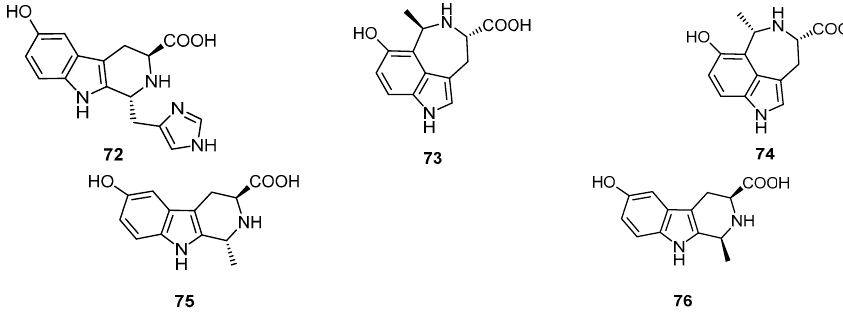
Figure 19. Chemical structures of hyrtioreticulin A ( 72 ), hyrtioreticulins C-E ( 73 – 75 ) and hyrtioerectine B ( 76 ).